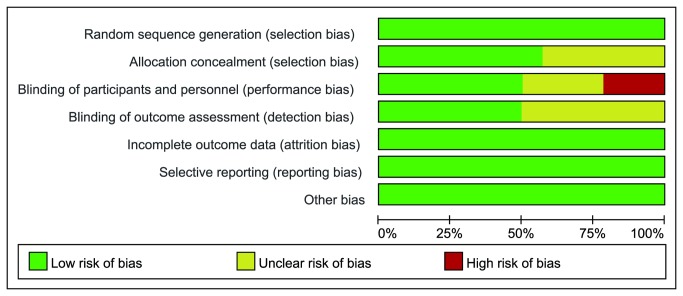
Risk of bias graph.